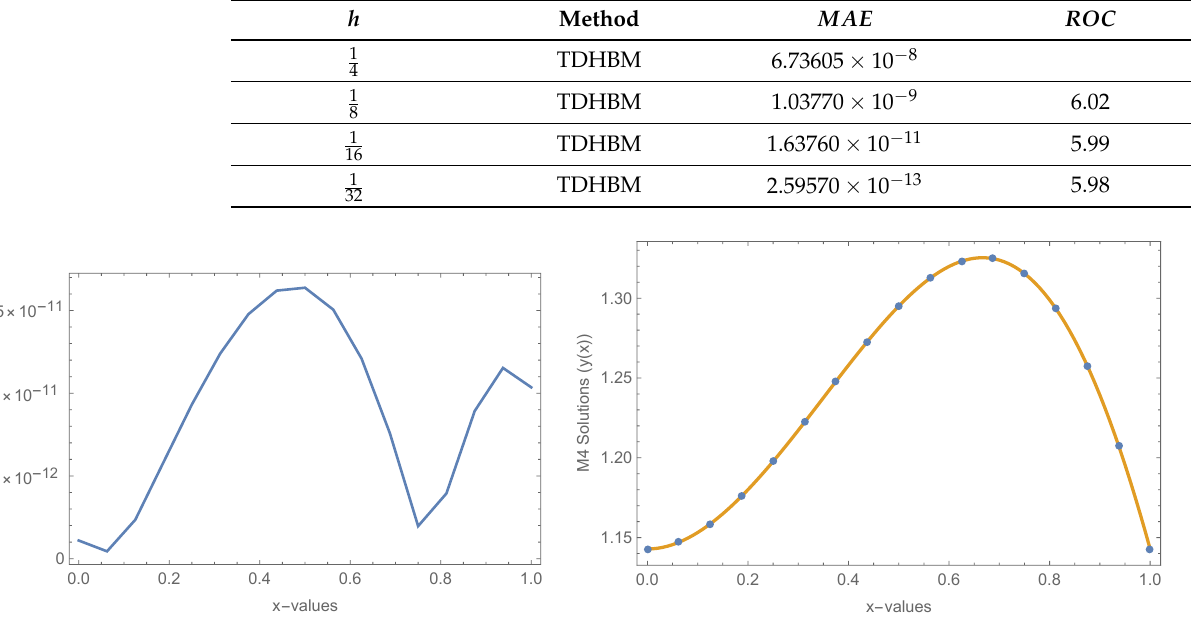
Figure 1. Plots of absolute errors ( left ), exact and TDHBM solutions ( right ) for Problem (22) with r = 1, R = 1 , M pe = 8, h = 1 8 16